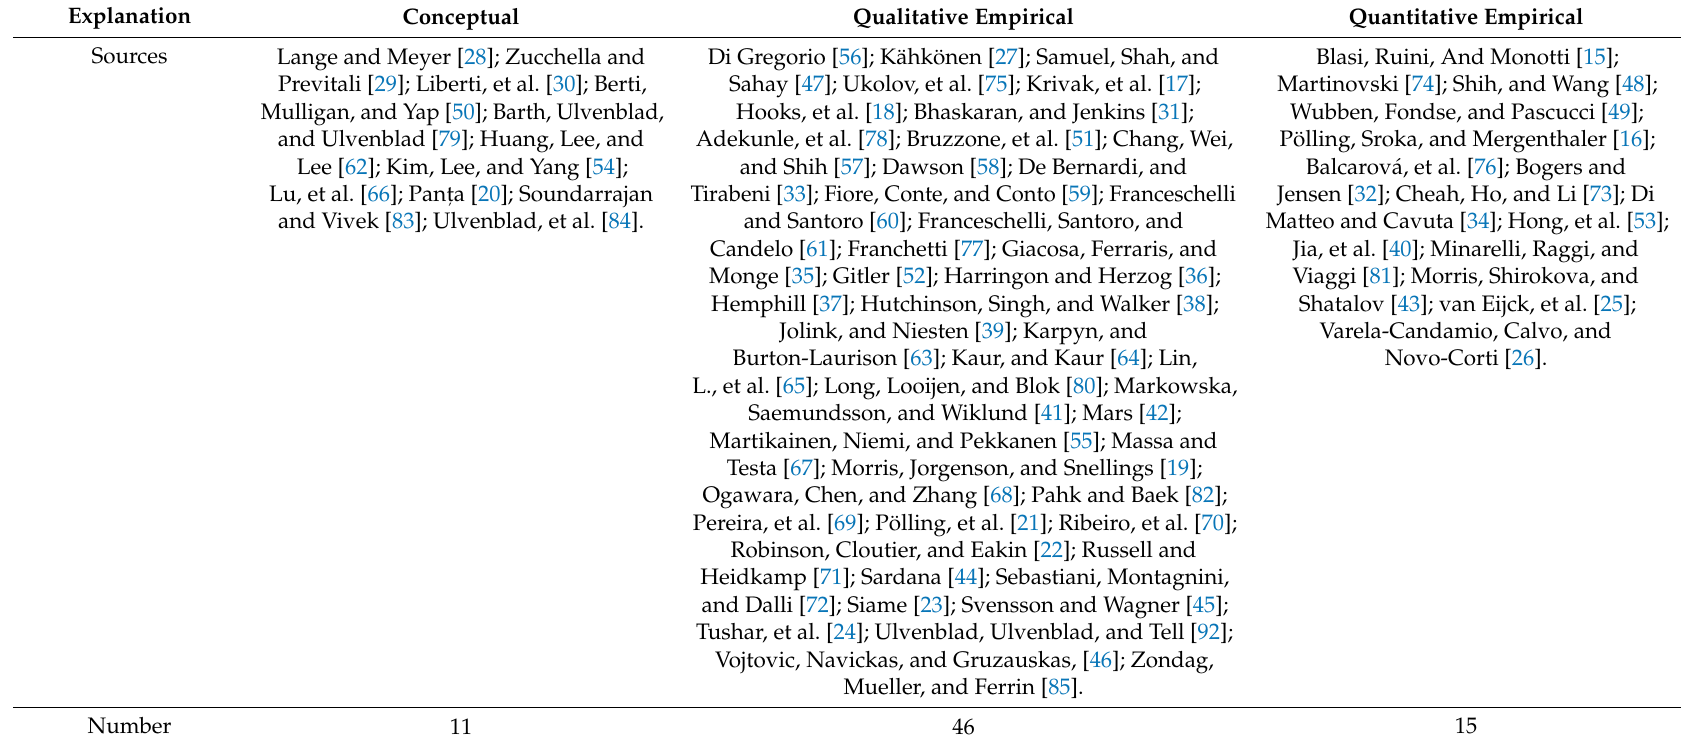
Table 3. Documents based on research